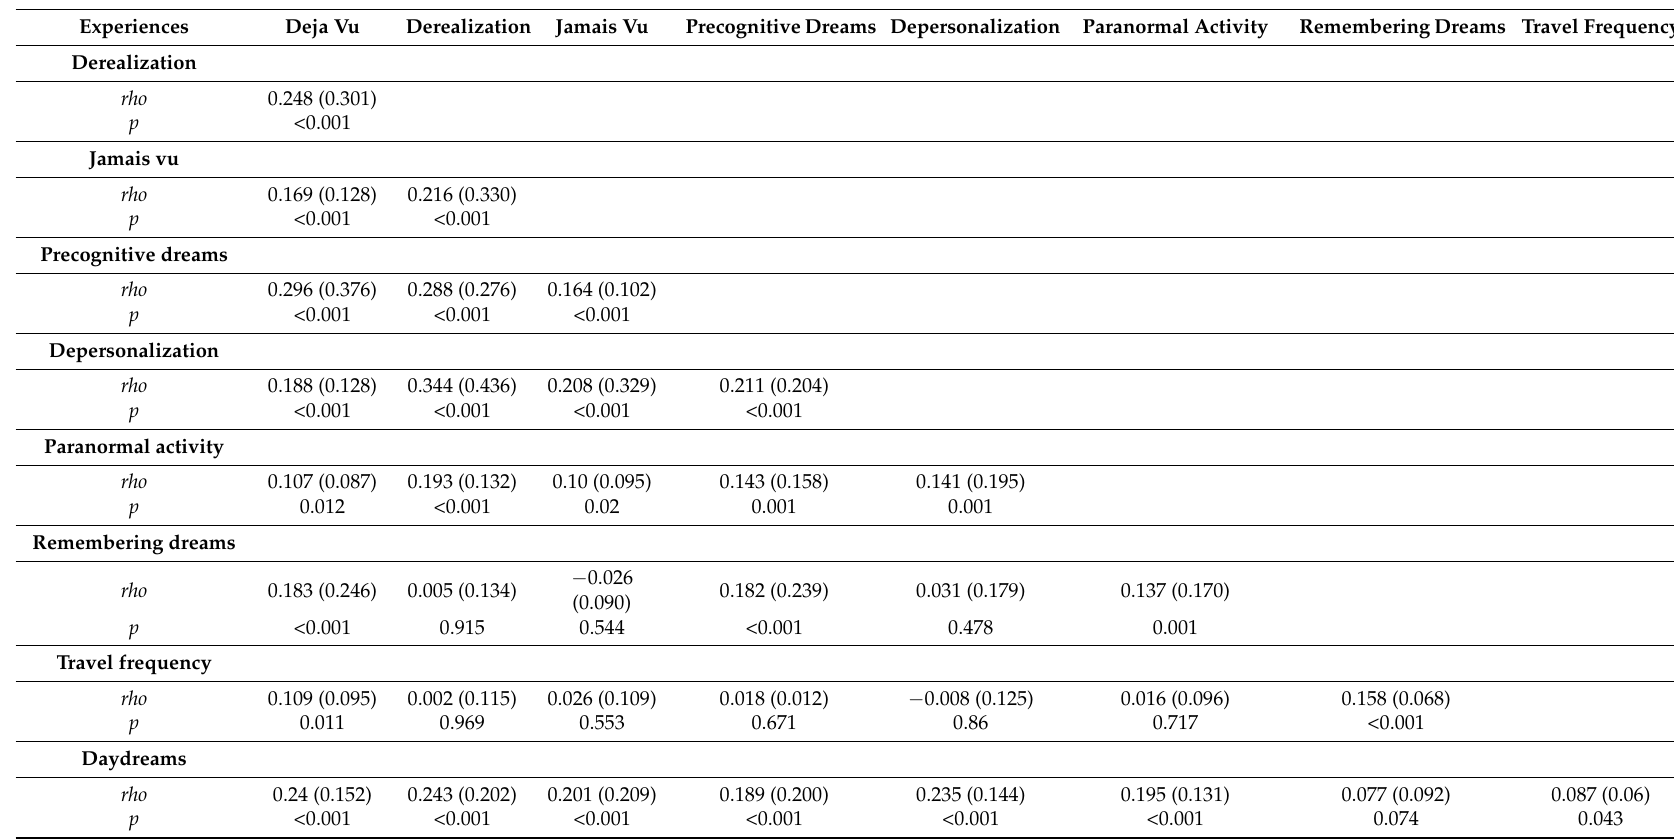
Table 3. Relation between the IDEA